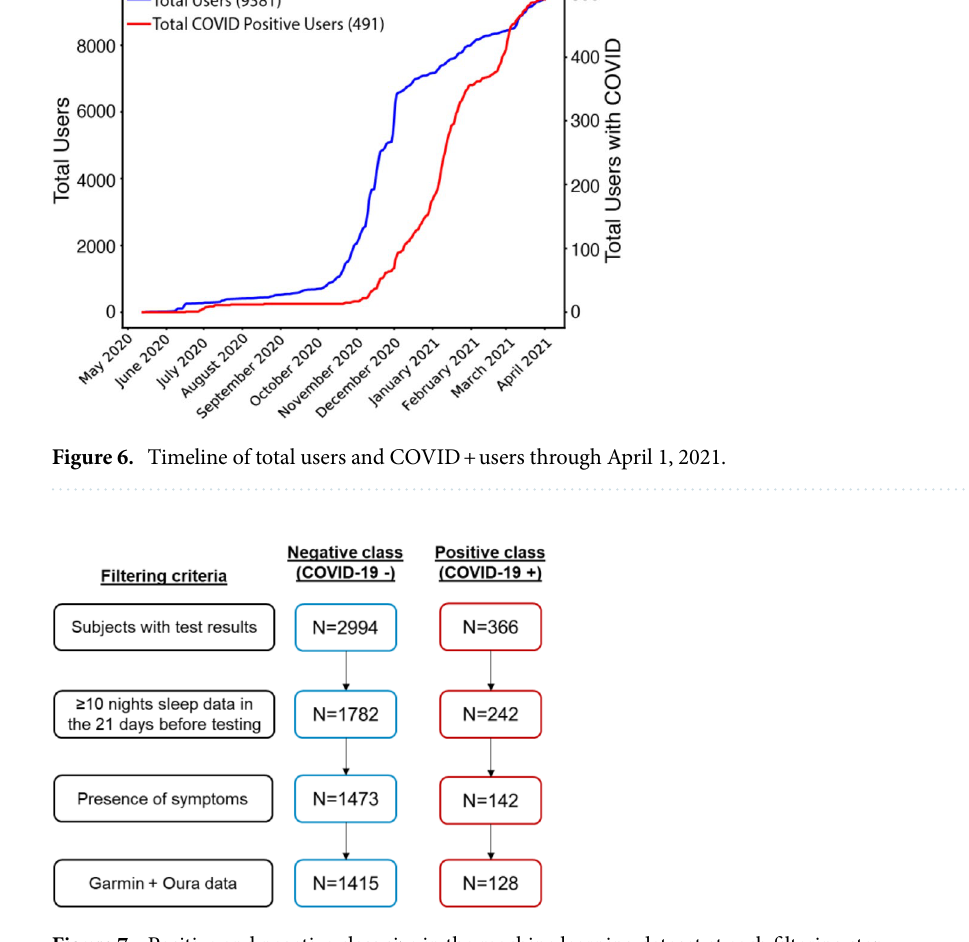
Figure 7. Positive and negative class size in the machine learning dataset at each filtering